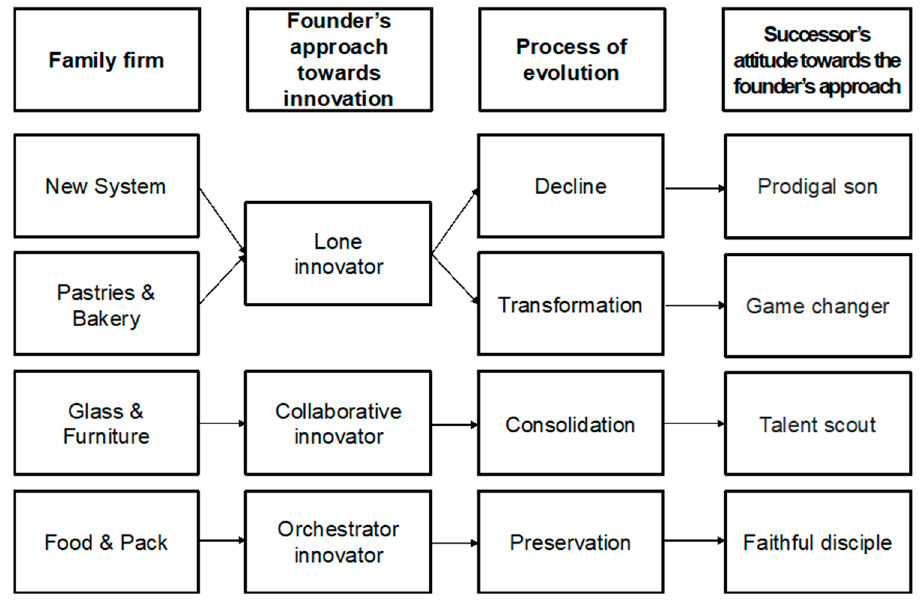
Figure 1. The evolution of the family firm’s innovativeness from the first to the second